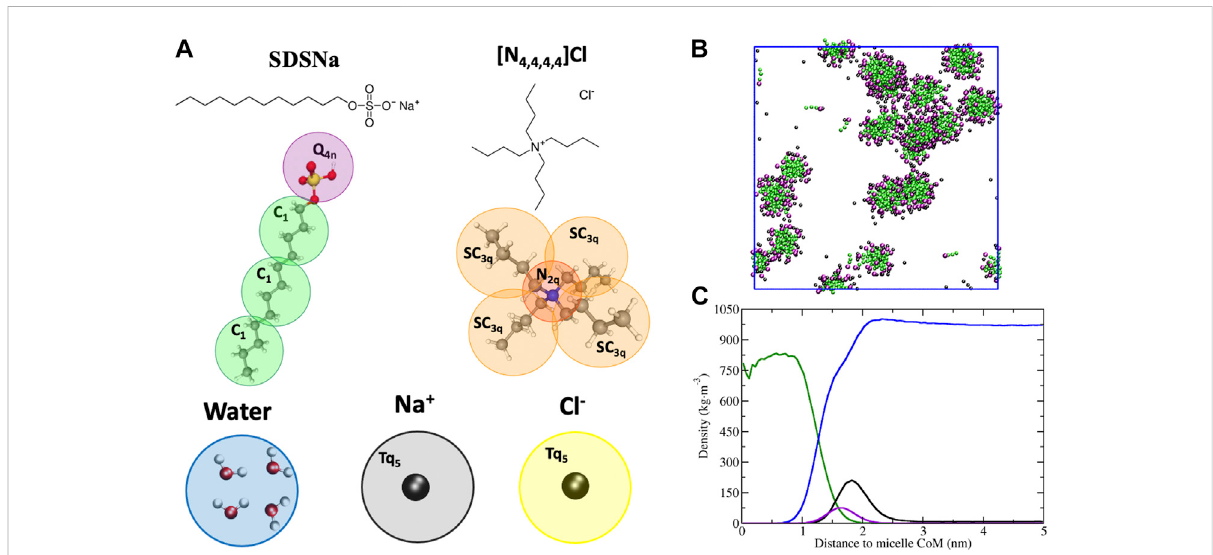
FIGURE 1 (A) CG mapping scheme for [DS] - , [N 4,4,4,4 ] + , water, sodium and chloride counter ions in MARTINI 3. The [DS] - consists of three C 1 beads for the alkyl tail (green) and a Q 4n bead type for the hydrophilic Sulphur head group (purple). (Vainikka et al., 2021). The [N 4,4,4,4 ] + involves three SC 3q beads for the butyl groups (orange) and a N 2q bead type for the ammonium center (red) with a partial charge of 0.372, with four U dummy beads used to delocalize (partial charge 0.157 each) the head group charge in a more realistic way. (Souza et al., 2021). Cl − and Na + are represented by TQ 5 beads colored in yellow and grey, respectively, whereas the 4:1 mapping was selected for water. (B) Micellar solution obtained in the CG-MD simulation for 2 wt% SDS aqueous solution at 298K over 3 μ s. (C) Averaged micelle density pro fi le of the system shown in (B) . The color code is as follows: [DS] - alkyl tailsin green,Sulphurhead group inpurple, sodium inblack andwater in blue. Thewater wasremoved inthesimulation snapshot (B) for